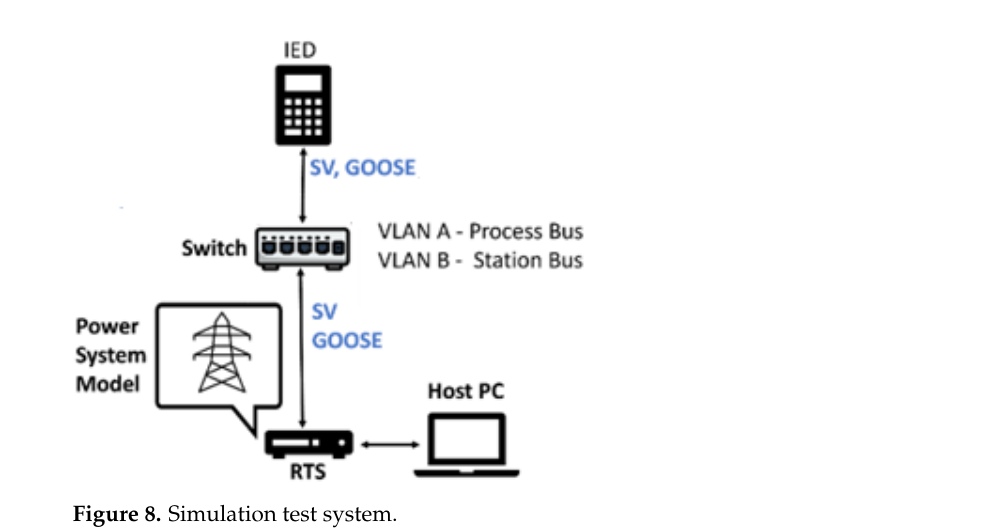
Figure 8. Simulation test system.